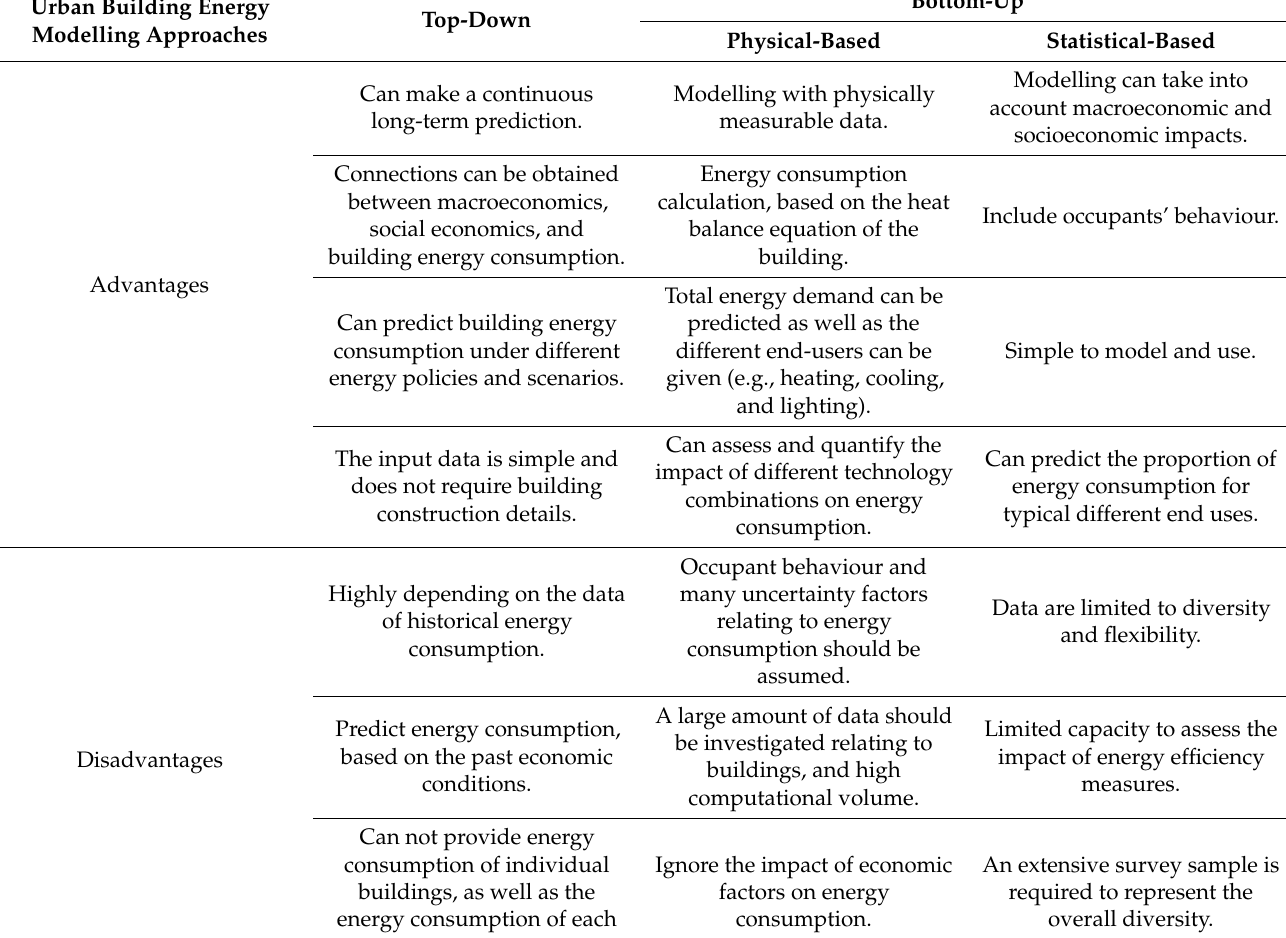
Table 1. Comparison of urban building energy modelling approaches